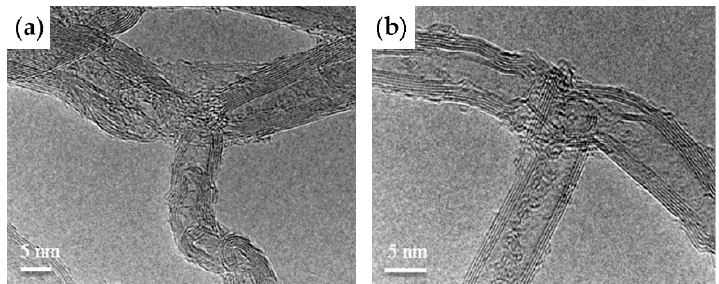
Figure 2. High-resolution transmission electron microscopy (HR-TEM) micrographs of ( a ) Y-junction MWCNTs; ( b ) T-junction MWCNTs. Reproduced from [16].